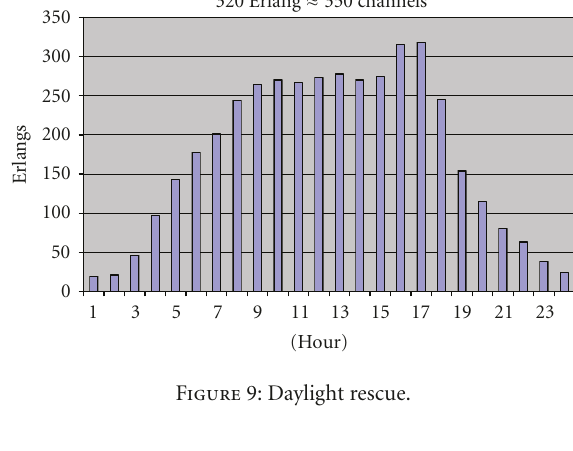
Figure 9: Daylight rescue.